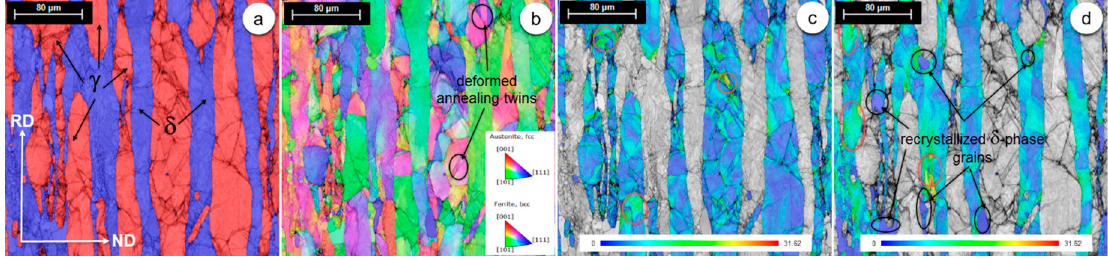
Figure 4. Distribution maps of both the γ - and δ -phases ( a ), inverse pole figure (IPF) ( b ), GROD map of the γ -phase ( c ) and δ -phase ( d ) for the hot-rolled ( HR ) state.